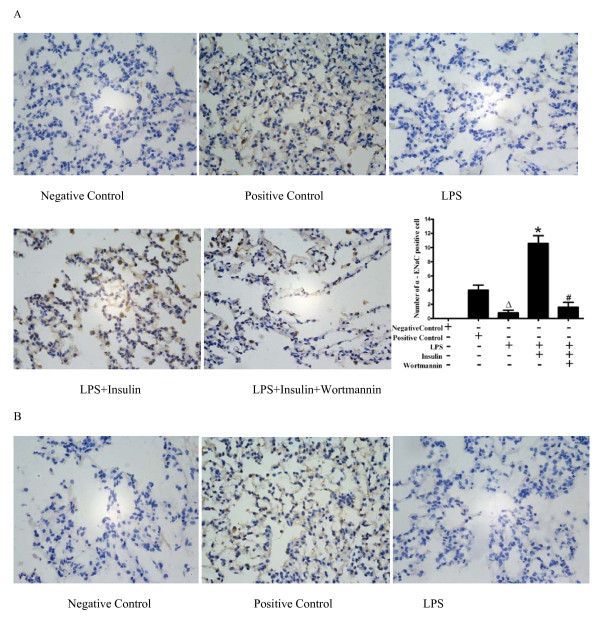
Effect of exogenous insulin on the protein expression of α- ENaC(A), β- ENaC(B), and γ-ENaC(C) in rat lung 8 hours after LPS-induced actue lung injury or saline treatment. The number of positive cells was counted in randomly 5 high-power fields of each section and averaged (five sections from 5 rats in each group). The number of cells expressing α-, β-, and γ-ENaC were significantly decreased in LPS-induced actue lung injury, compared with those in positive control group. However, the number of cells expressing α-, β-, and γ-ENaC were strongly increased by insulin treatment, but were decreased by wortmannin. Brown immunostained cell was positive (original magnification 400 ×).ΔP < 0.05 vs Positive control group;*P < 0.05 vs LPS group;# P < 0.05 vs LPS + Insulin group.